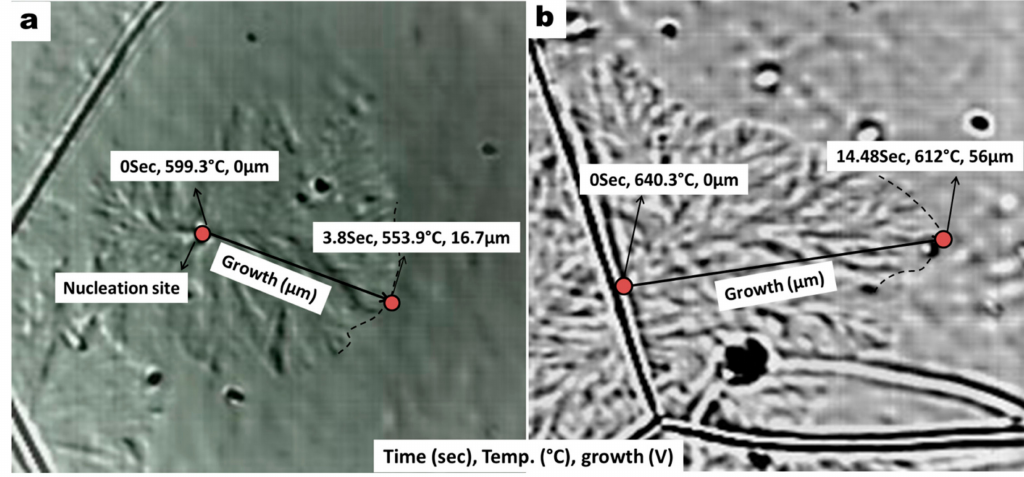
Figure 10. Pearlite growth at di ff erent times and temperatures. ( a ) 4 ◦ C / s. ( b ) 1 ◦ C /